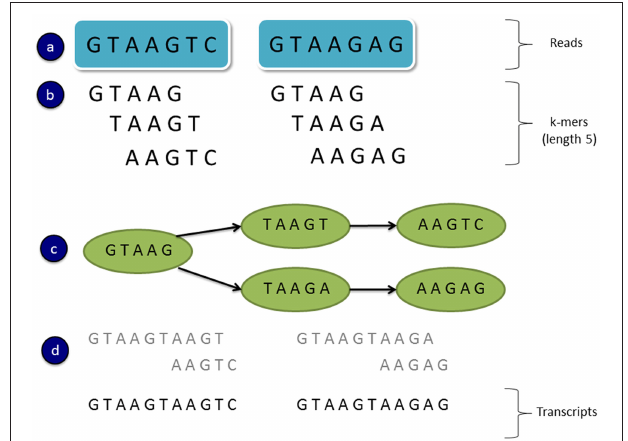
FIGURE 2 | An example of a simple de Bruijn graph. (A) Read sequences (B) All subsequence k-mers of length 5 from the reads (C) A de Bruijn graph constructed from unique k-mers as the nodes and overlapping k-mers connected by edges (a k-mer shifted by one base overlaps another k-mer